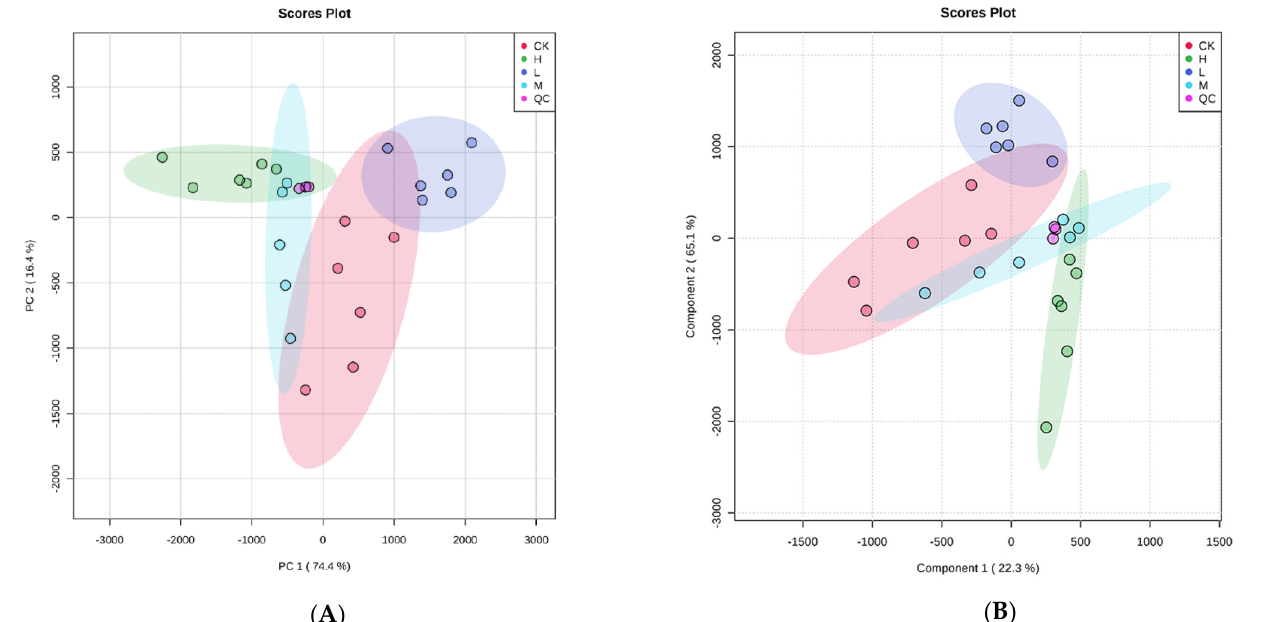
Figure 3. Principal component analysis (PCA) ( A ) and partial least-squares discriminate analysis (PLS-DA) score plots ( B ) of metabolic profiles in Arabidopsis thaliana treated with Eupatorium adenophorum aqueous extracts. Abbreviations: CK—control; L—treated by aqueous extract in low concentration; M—treated by aqueous extract in medium concentration; H—treated by aqueous extract in high concentration; QC—quality control, i.e., the sample prepared by mixing aliquots of all samples.